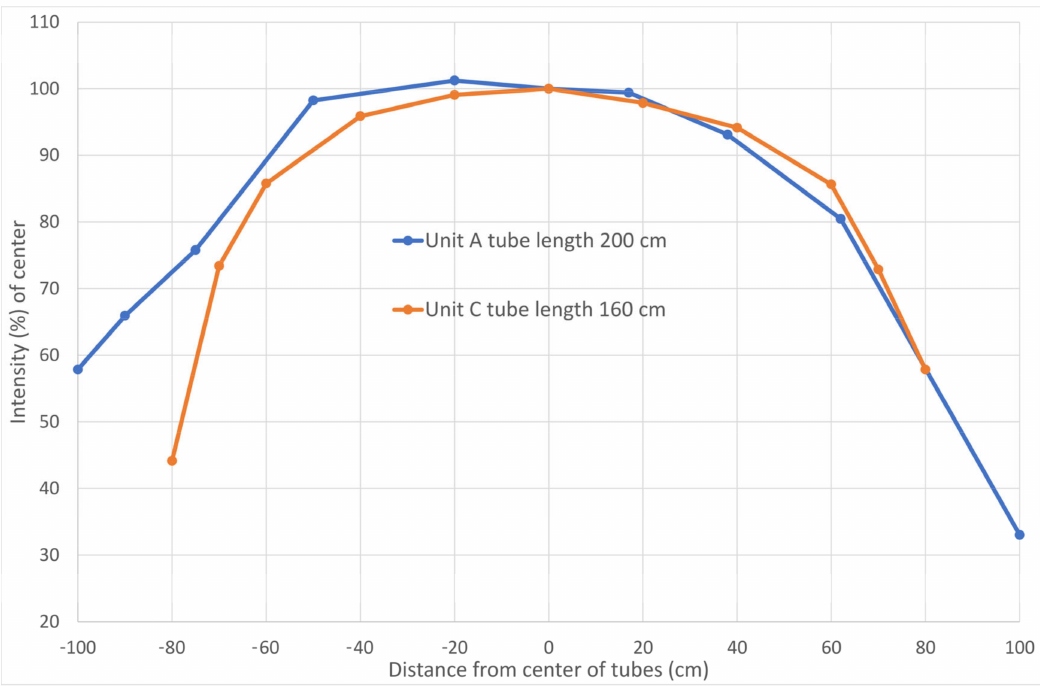
Figure 4. Light intensity in % of the intensity in the middle of the tubes. Measurements are performed at the center of the treatment unit. More than 80% intensity is obtained in the middle 133 cm of the tubes in unit A and in the middle 129 cm of the tubes in unit C. Some of the differences may be caused by measuring the tubes in their full length (200 cm) in treatment unit A, but only measuring 160 cm of total tube length (180 cm) in unit C where approximately 10 cm of both tube ends are covered by